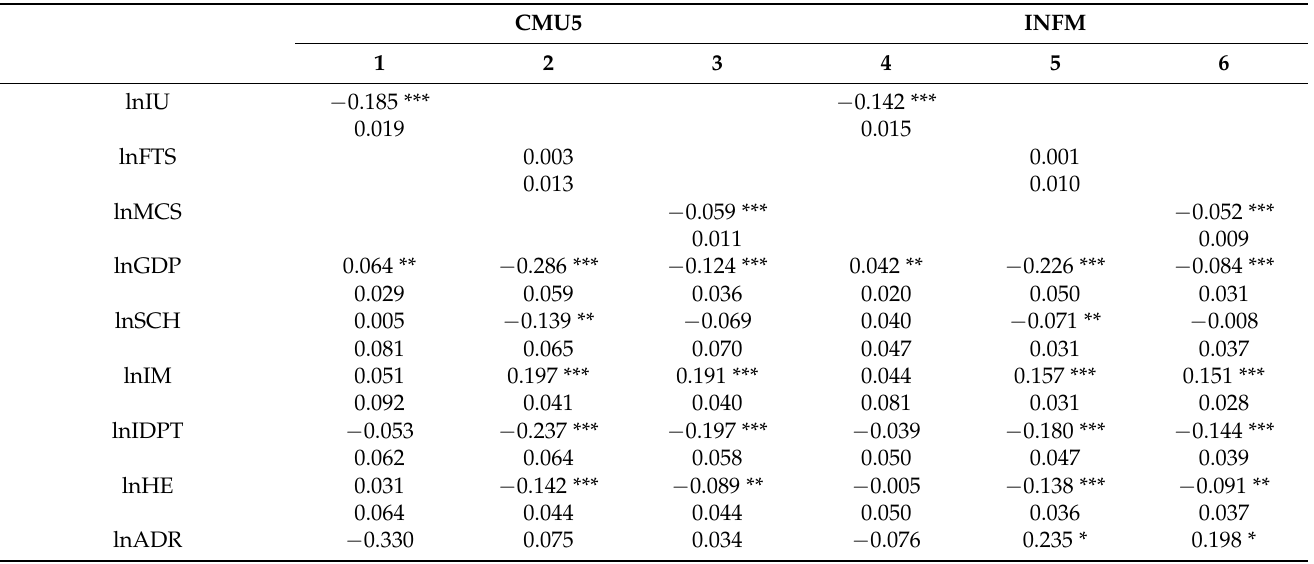
Table A3. FE using Driscoll–Kraay robust errors with IV estimation results for INFM and child mortality under